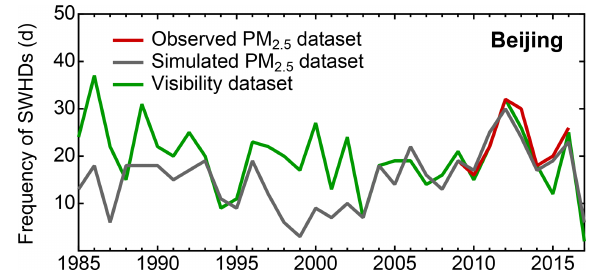
Figure 5. Temporal evolutions of SWHD frequency (days per DJF) at the Beijing grid, which were derived from observed PM 2 . 5 (red, 2009–2016), simulated PM 2 . 5 (gray, 1985–2017), and observed at- mospheric visibility (green,